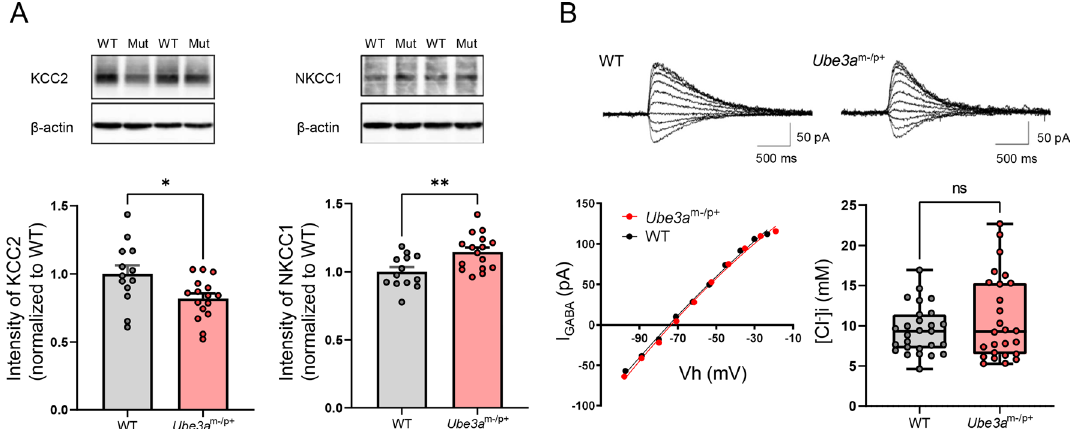
Figure 1. Homeostatic regulation of neuronal intracellular Cl − levels in Ube3a m−/p+ mice. ( A ) Western blot analysis of the K + -Cl − cotransporter 2 (KCC2) and Na + -K + -Cl − cotransporter 1 (NKCC1) expression in hippocampus tissue lysates from wild-type (WT; n = 13) and Ube3a m−/p+ (n = 16) mice. The upper panels show KCC2 and NKCC1 immunoblots from two mice from each group. Wild type and Ube3a m−/p+ are abbreviated as “WT” and “Mut,” respectively. The original gels are shown in Supplementary information Fig. S1 and Fig. S2. The lower left and right panels show the quantification of KCC2 and NKCC1 expression. The KCC2 and NKCC1 band intensities were normalized to the β-actin band intensity. ( B ) The Upper panels show representative GABA-induced current traces at different command potentials under gramicidin-perforated patch-clamp recordings. The current–voltage relationship estimated from the peak current measured during the responses is plotted in the left lower panel. The right lower panel shows intracellular Cl − concentration ([Cl − ] i ) of CA1 pyramidal neurons calculated from the reversal potentials of GABA-mediated currents determined in gramicidin perforated patch-clamp recordings. The lines in each box depict the lower quartile, median, and upper quartile values. The whiskers extending from each end of a box depict the minimum and maximum ranges. The [Cl − ] i values are not significantly different between WT (n = 27 cells) and Ube3a m−/p+ (n = 26 cells) groups, but are more widely distributed in Ube3a m−/p+ mice than in WT animals ( F test for equality of variance, p < 0.01). Data are presented as the mean ± SEM, * p < 0.05; ** p < 0.01, ns not significant by the unpaired t